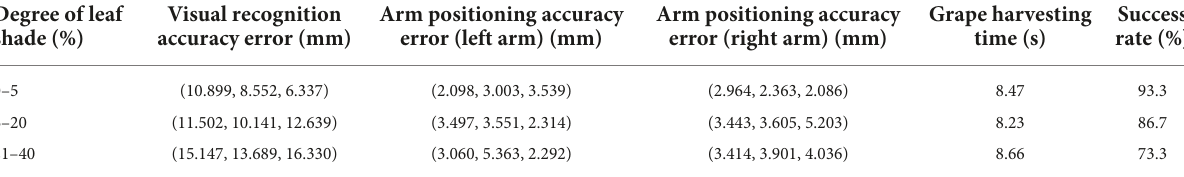
TABLE 2 Accuracy experiment results.